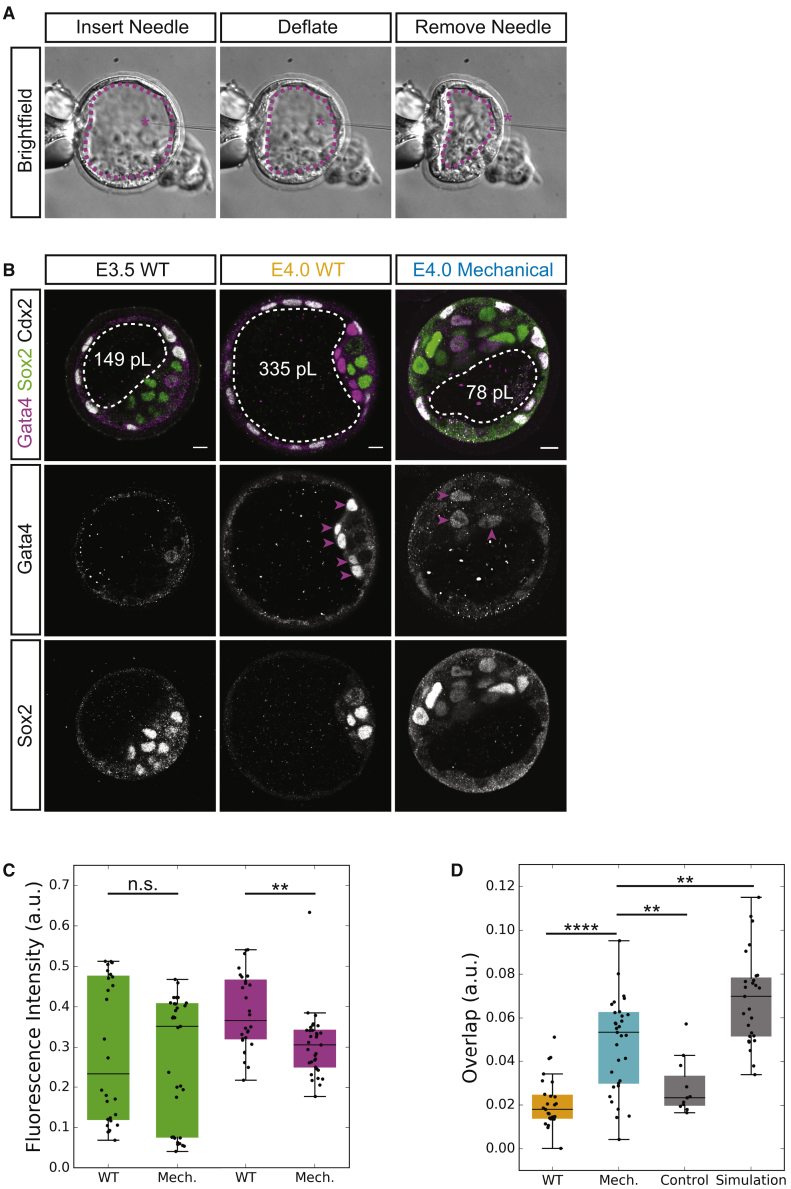
PrE Specification and Spatial Segregation of ICM Lineages Is Impaired by Mechanical Inhibition of Lumen Expansion(A) Brightfield images of mechanical deflation. Magenta asterisk marks the needle tip. Dotted magenta line indicates lumen boundary.(B) Immunofluorescence images of EPI (Sox2) and PrE (Gata4) fate in pre-manipulation control (E3.5 WT), E4.0 post-manipulation control (E4.0 WT), and E4.0 mechanically inhibited (E4.0 Mechanical) embryos. Magenta arrowheads indicate the position of cells expressing high levels of Gata4 within the ICM. White dotted line indicates lumen boundaries. Average lumen volume in white text. Scale bars, 10 μm.(C) Boxplot of fluorescence levels of Sox2 (green) and Gata4 (magenta) in mechanically inhibited (Mech., N = 33) and post-manipulation control (WT, N = 28) E4.0 embryos.(D) Boxplot of spatial overlap between EPI and PrE lineages within post-manipulation control (WT, N = 27), mechanically inhibited (Mech., N = 33), E4.0 procedural control (Control, N = 11), and E4.0 simulation of complete overlap in WT conditions (Simulation, N = 27).∗∗∗∗p < 0.0001, ∗∗p < 0.01. n.s., not significant.For boxplots: central mark indicates the median; lower edge, 25%; upper edge, 75%; lower whisker, Q1 − (1.5 × IQR), where IQR = Q3 − Q1; upper whisker, Q3 + (1.5 × IQR).See also Figure S6 and Table S2.